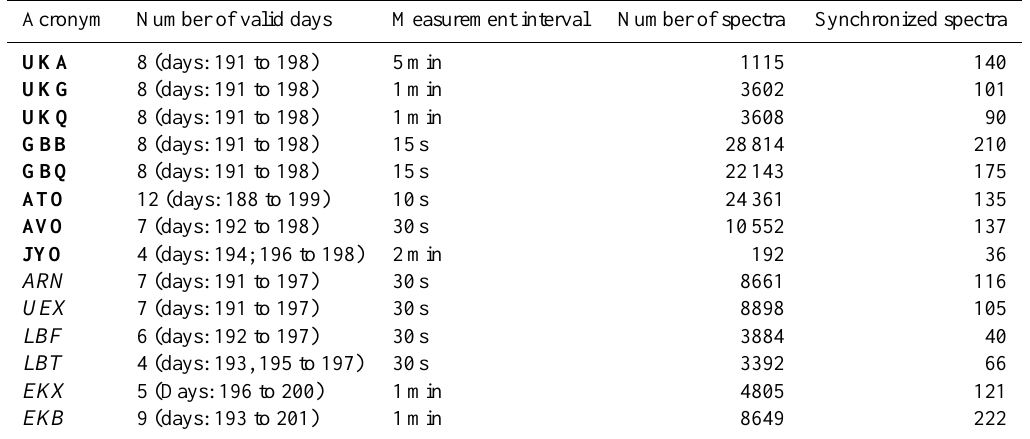
Table 2. Summary of available solar UV data from all ASRMs participating at the intercomparison: ASRMs record the entire spectrum quasi- instantaneously at a specific measurement interval, which is generally shorter than the interval of the scanning spectroradiometer QASUME. The number of spectra which were synchronized to QASUME are indicated. The number of valid days are counted from 1 January 2014. Acronym Number of valid days Measurement interval Number of spectra Synchronized